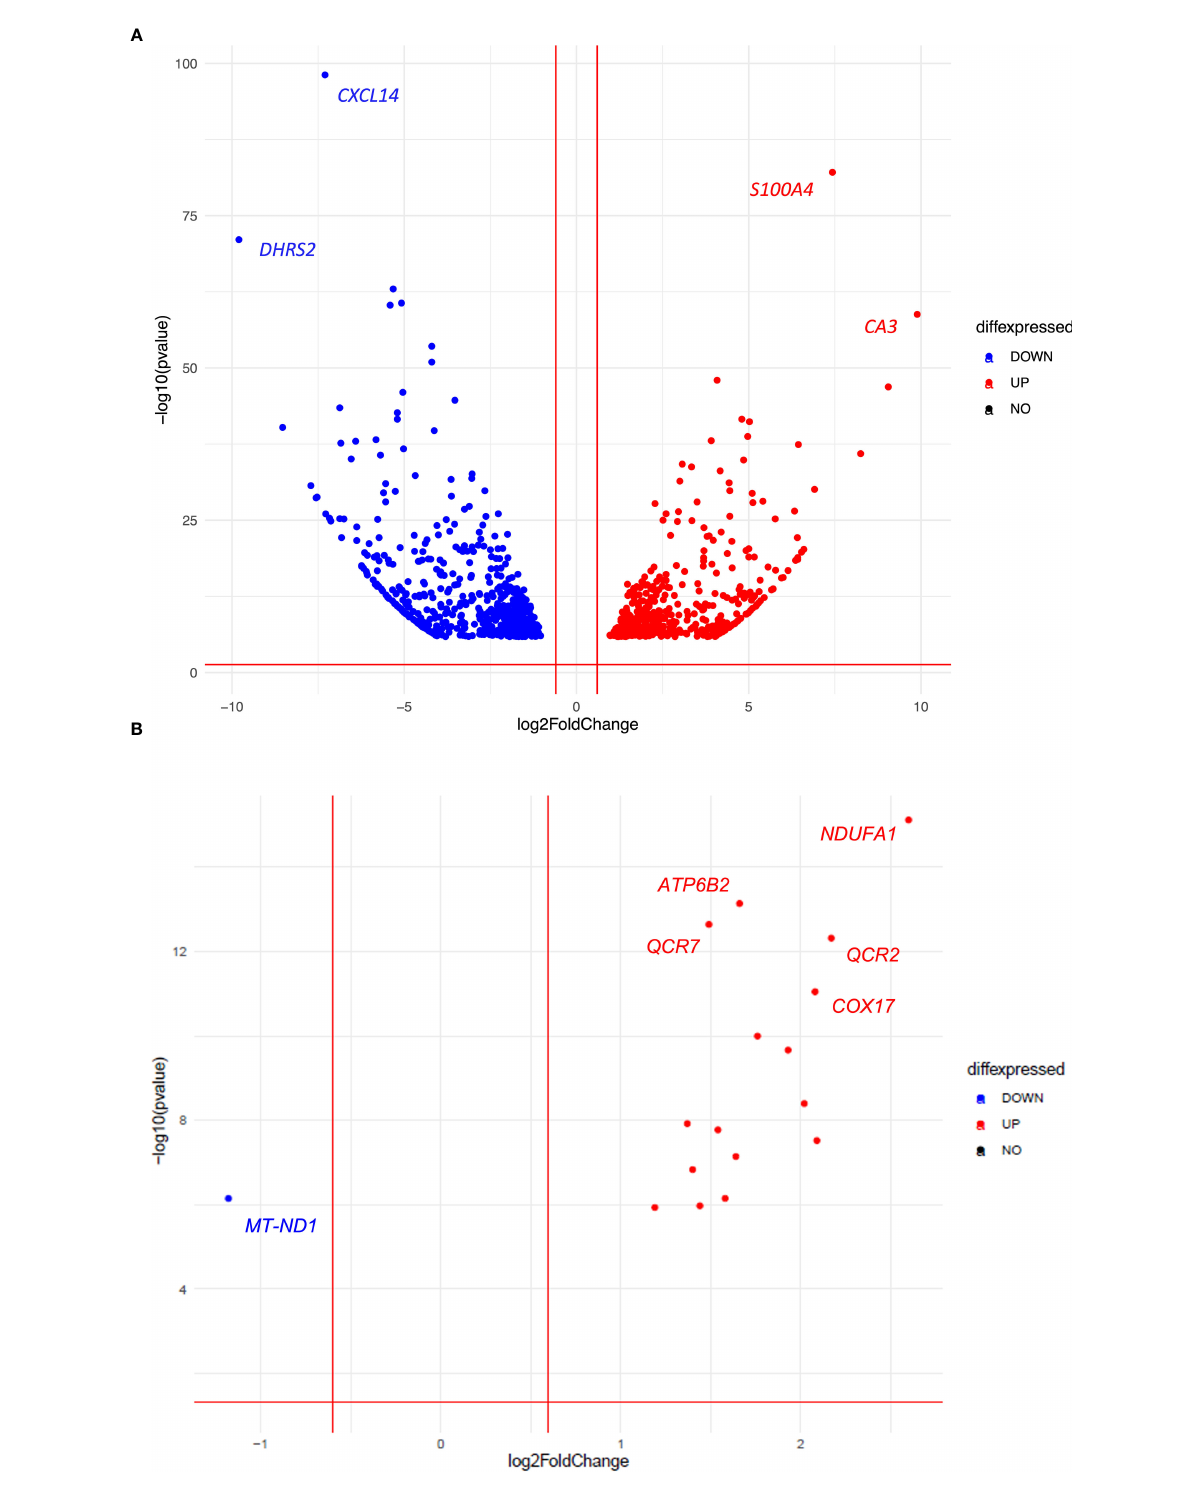
FIGURE 5 Volcanoplots illustrating the top 1000 genes (A) and all genes related to the oxidative phosphorylation (OxPhos) pathway (B) , in which we observed a signi fi cant gene expression variation in both untreated CD3 and CD7 PDX models (adjusted